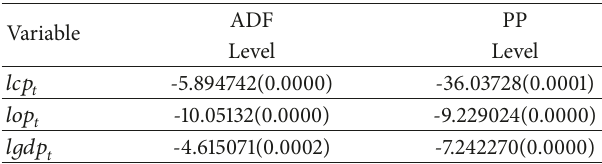
Table 2: Unit root test results of sequence first-order